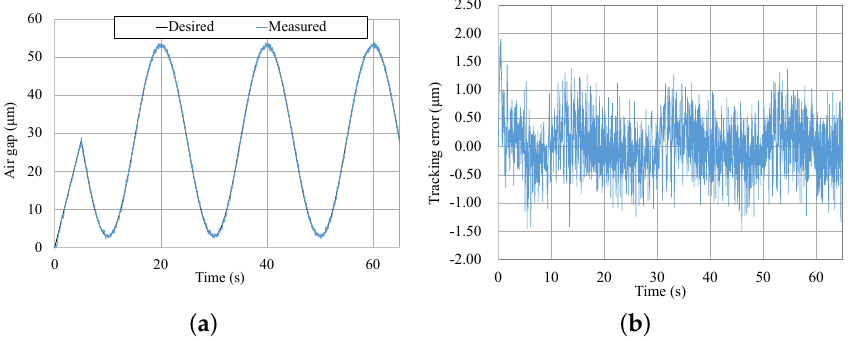
Figure 13. Tracking results of the waved trajectory. ( a ) Tracking result of desired trajectory. ( b ) Track- ing error of desired trajectory.